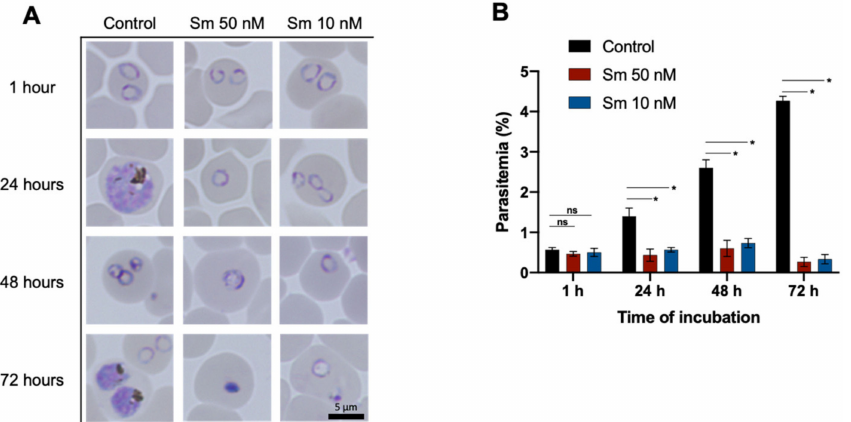
Figure 2. Representative morphology and parasitemia levels of parasites under no treatment (control) or sparsomycin (Sm) treatment (50 nM and 10 nM). ( A ) Parasite morphology after 1, 24, 48 and 72 h of incubation. The parasites in the treated group were retained in the ring stage, they were shrunken and they could not form trophozoites in the life cycle. Scale bar: 5 µ m. ( B ) Parasitemia levels after 1, 24, 48 and 72 h of incubation. Parasitemia levels are presented as the mean of triplicate wells and the error bars represent standard deviations. *, significant ( p < 0.05); ns, not significant ( p > 0.05). The significance of differences in the level of parasitemia of Sm-treated cultures compared with control were analyzed by two-way ANOVA and a Tukey’s multiple comparison test.